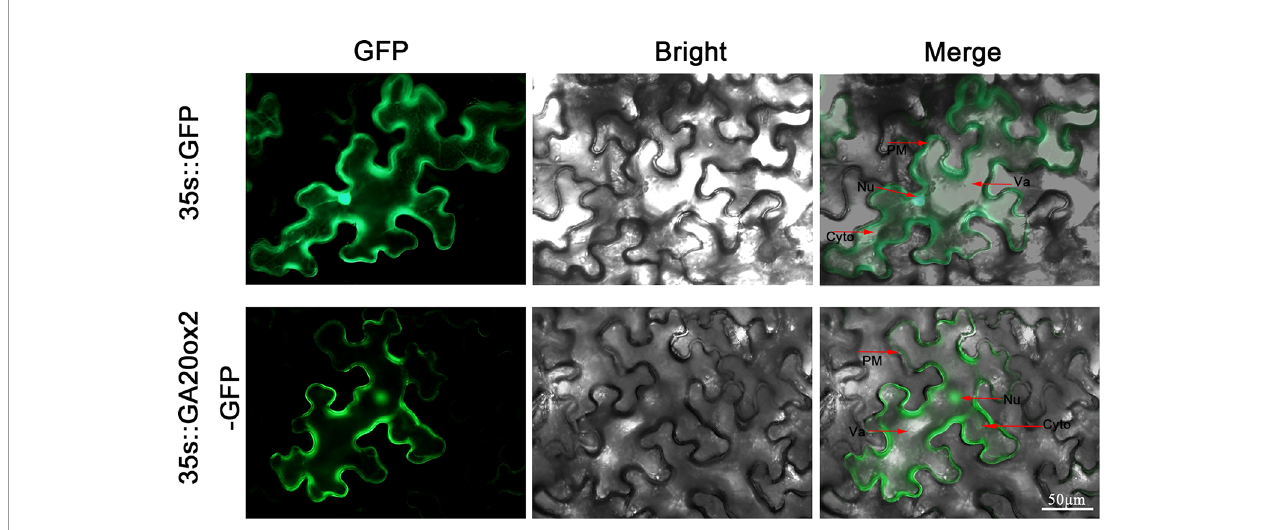
FIGURE 3 | Subcellular localization of PbGA20ox2 in tobacco leaves. The fusion protein (PbGA20ox2-GFP) and positive control (GFP) were independently transiently expressed in tobacco leaves. PbGA20ox2 was detected in the cytoplasm, nucleus, and plasma membrane. PM, plasma membrane; Nu, nucleus; Cyto, cytoplasm; Va, vacule.